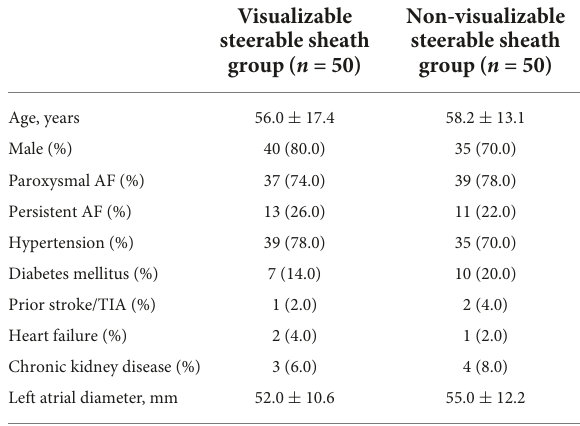
TABLE 1 Clinical characteristics of the study population.